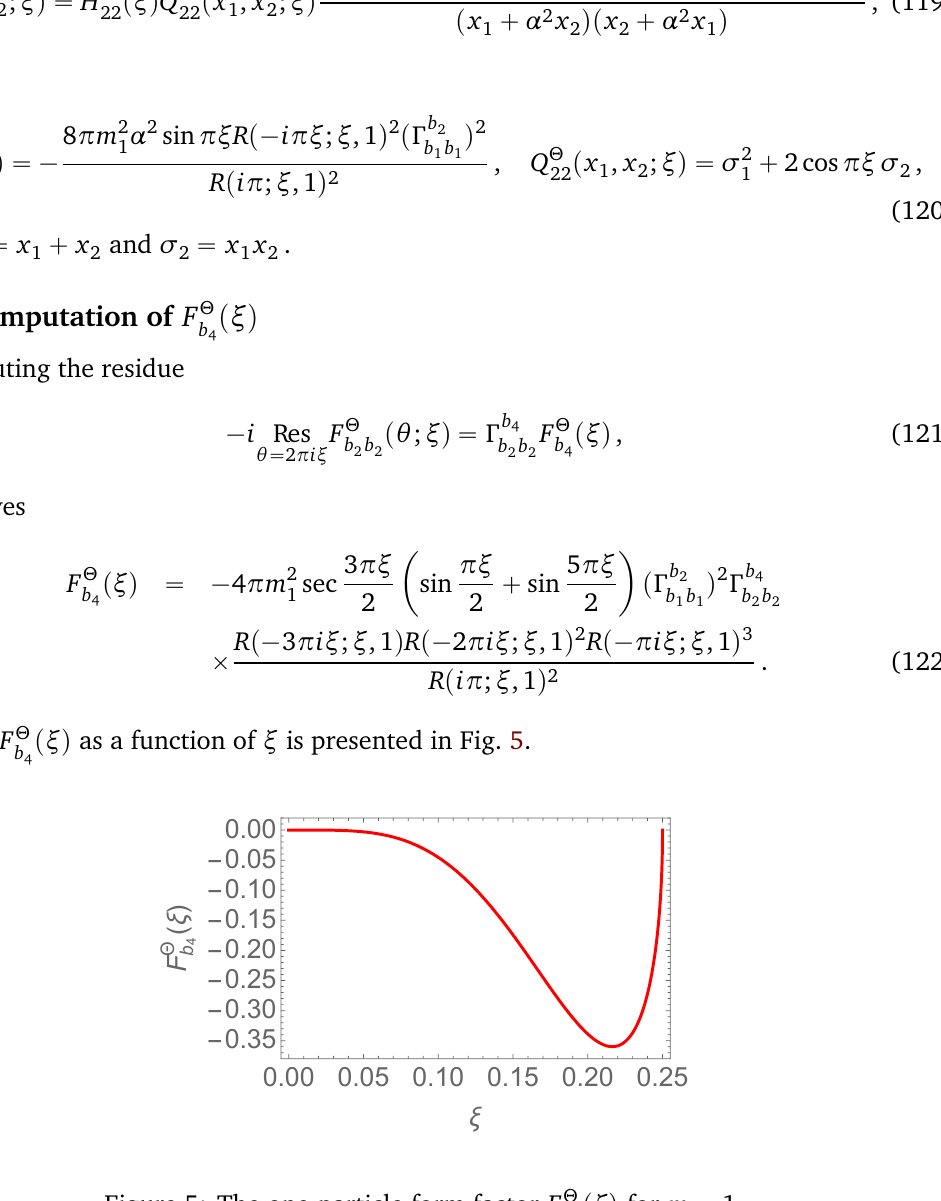
Figure 5: The one-particle form factor F Θ